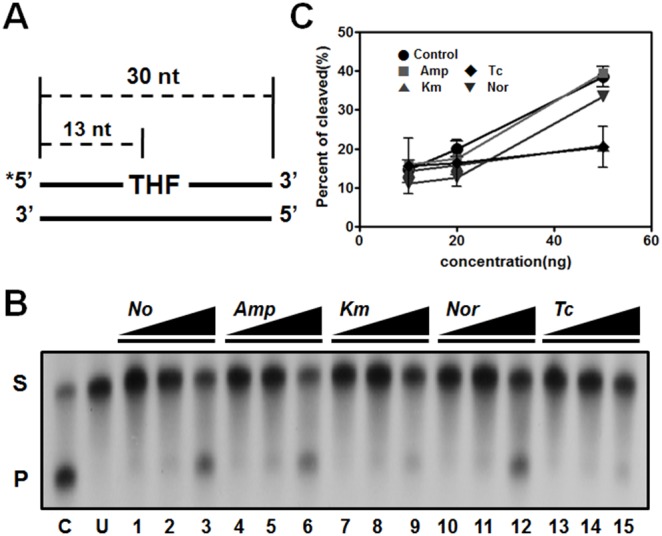
Verification of endonuclease IV activity by using the base-excision DNA-repair assay.DNA-repair capability of endonuclease IV was measured in DR1 exposed to distinct classes antibiotics. (A) Schematic representation of DNA substrate containing a site-specific THF residue. (B) A representative autoradiograph of gel electrophoresis to measure in vitro BER products. (C) Quantification of endonuclease IV BER activity. S, substrate; P, product; C, positive control; U, untreated negative control. Error bars indicate the S.D. calculated for each data point (n = 2).